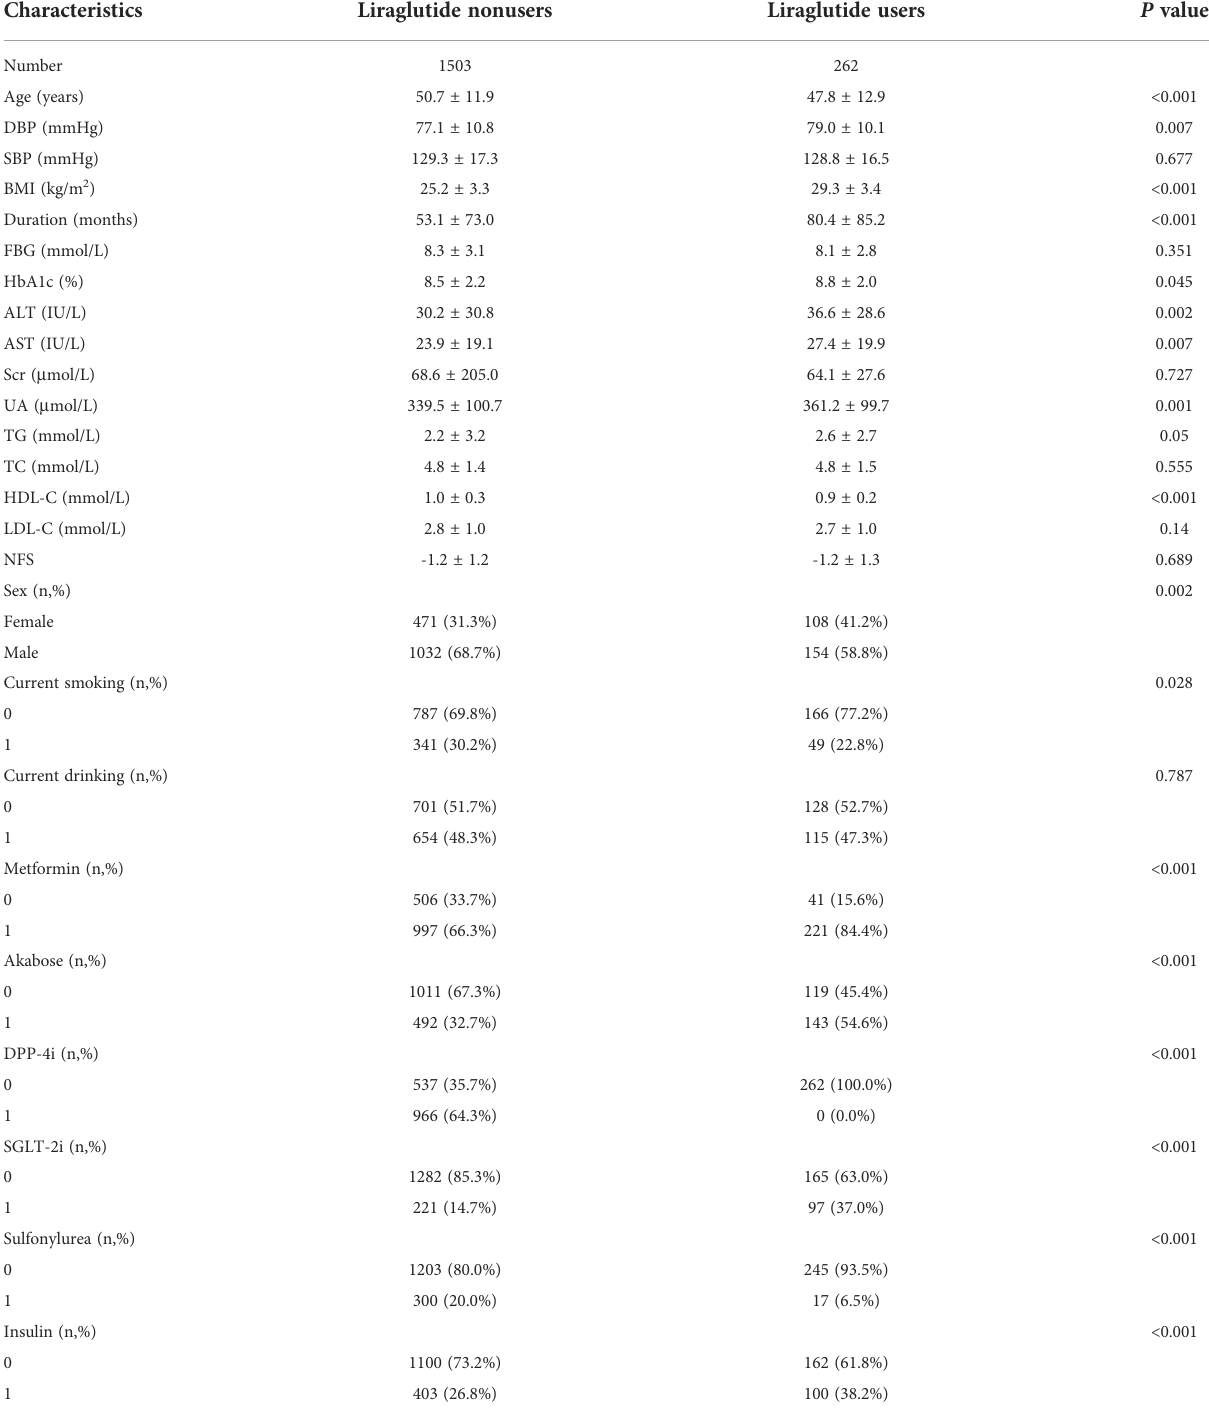
TABLE 1 Baseline data in the population according the use of liraglutide before